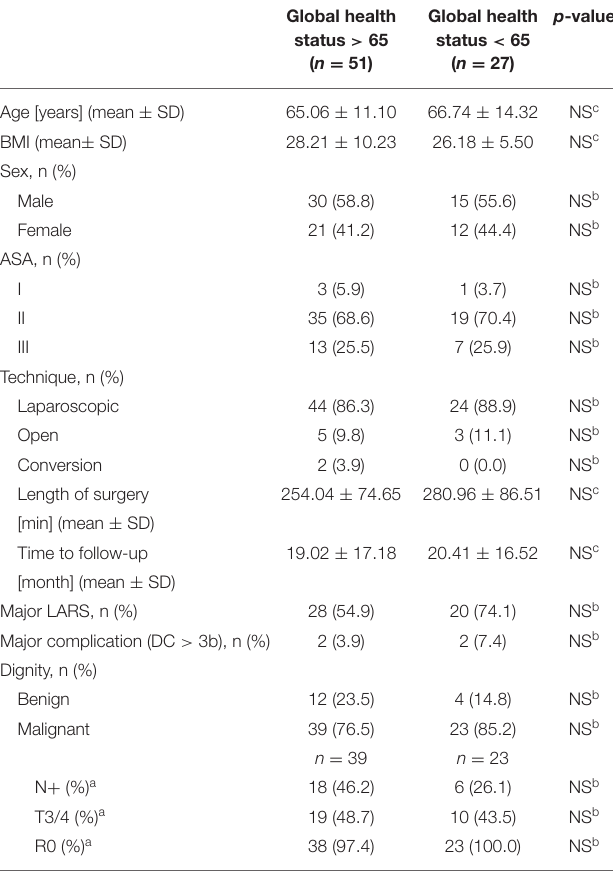
TABLE 2 | Patient characteristics according to the global health